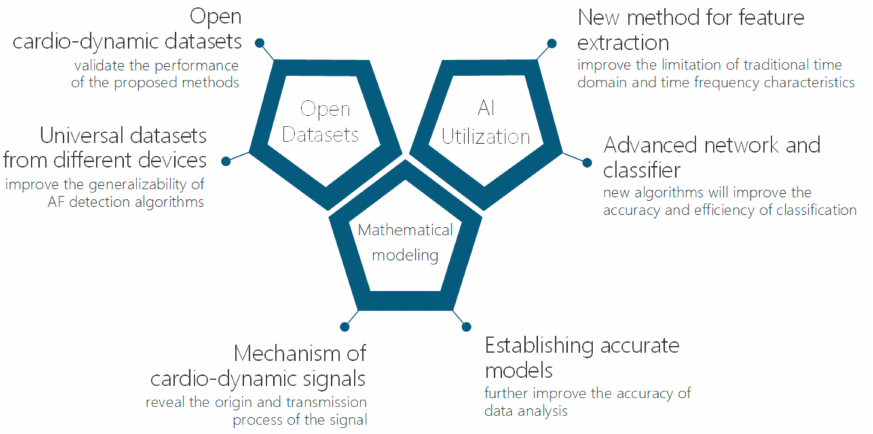
Figure 5. Future